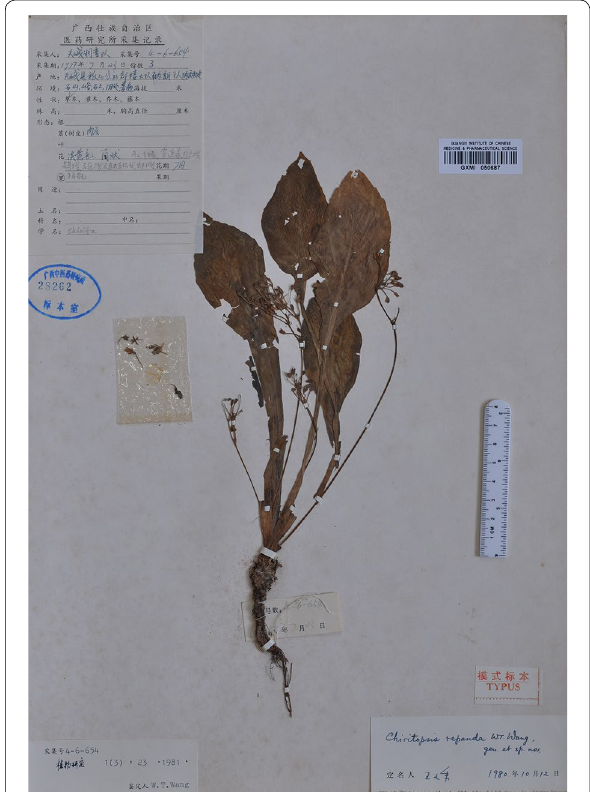
Fig. 9 Holotype of Chiritopsis cordifolia D.Fang & W.T.Wang [ D. ‑ H. Qin 51260